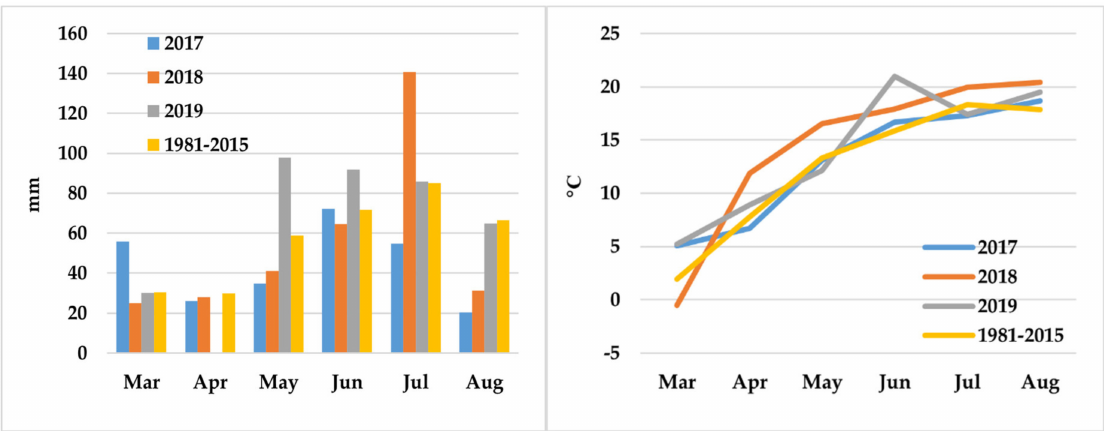
Figure 1. Total monthly rainfall (mm) and average monthly temperature ( ◦ C) during the growing season of crambe in 2017–2019 and the long-term average (1981–2015) at the experimental site.